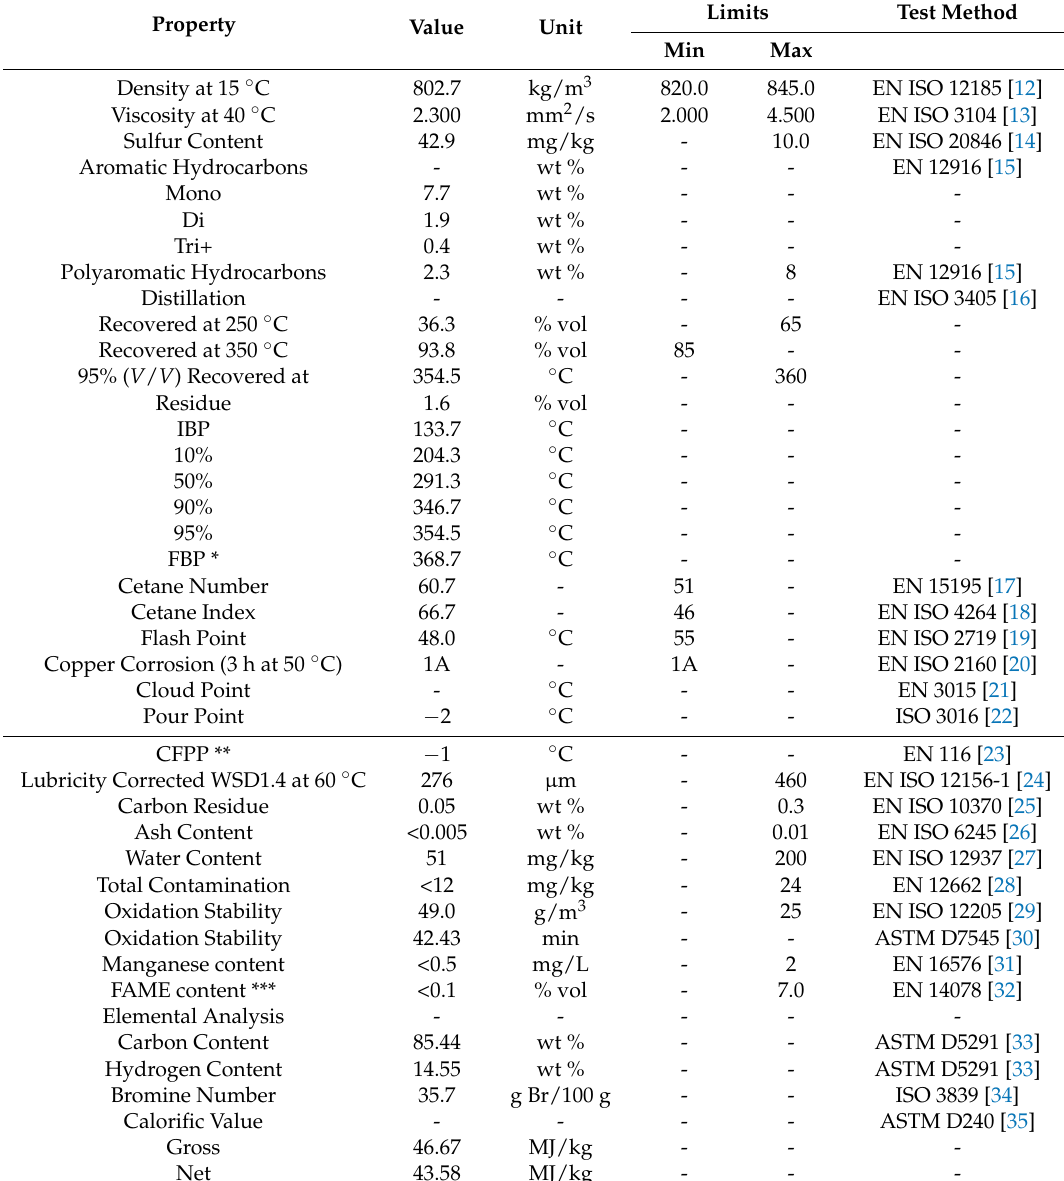
Table 2. Analysis of the mid-distillate fraction of the pyrolysis